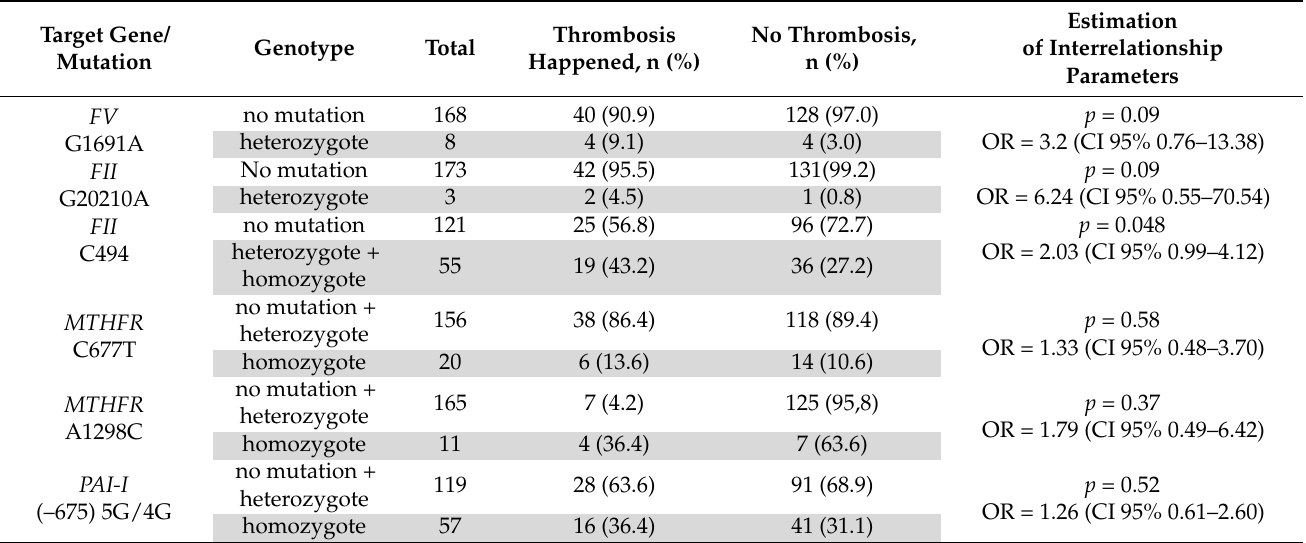
Table 4. Prevalence of thrombosis events in COVID-19 patients having various genetic thrombophilia